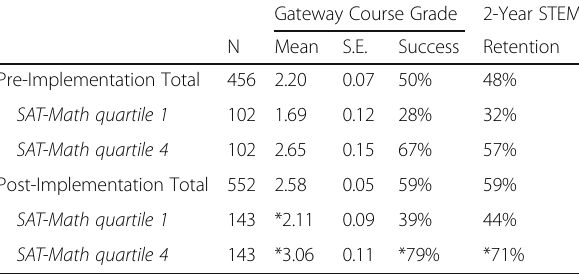
Table 9 Gateway course outcomes and STEM retention rates for students in the lowest and highest quartile of SAT-Math scores, pre- and post-implementation. In both groups, quartile 1 included SAT-Math scores of 0 – 480 and quartile 4 included scores of 590 – 800. *Pre- to post-implementation t -statistic indicated significant differences, p <